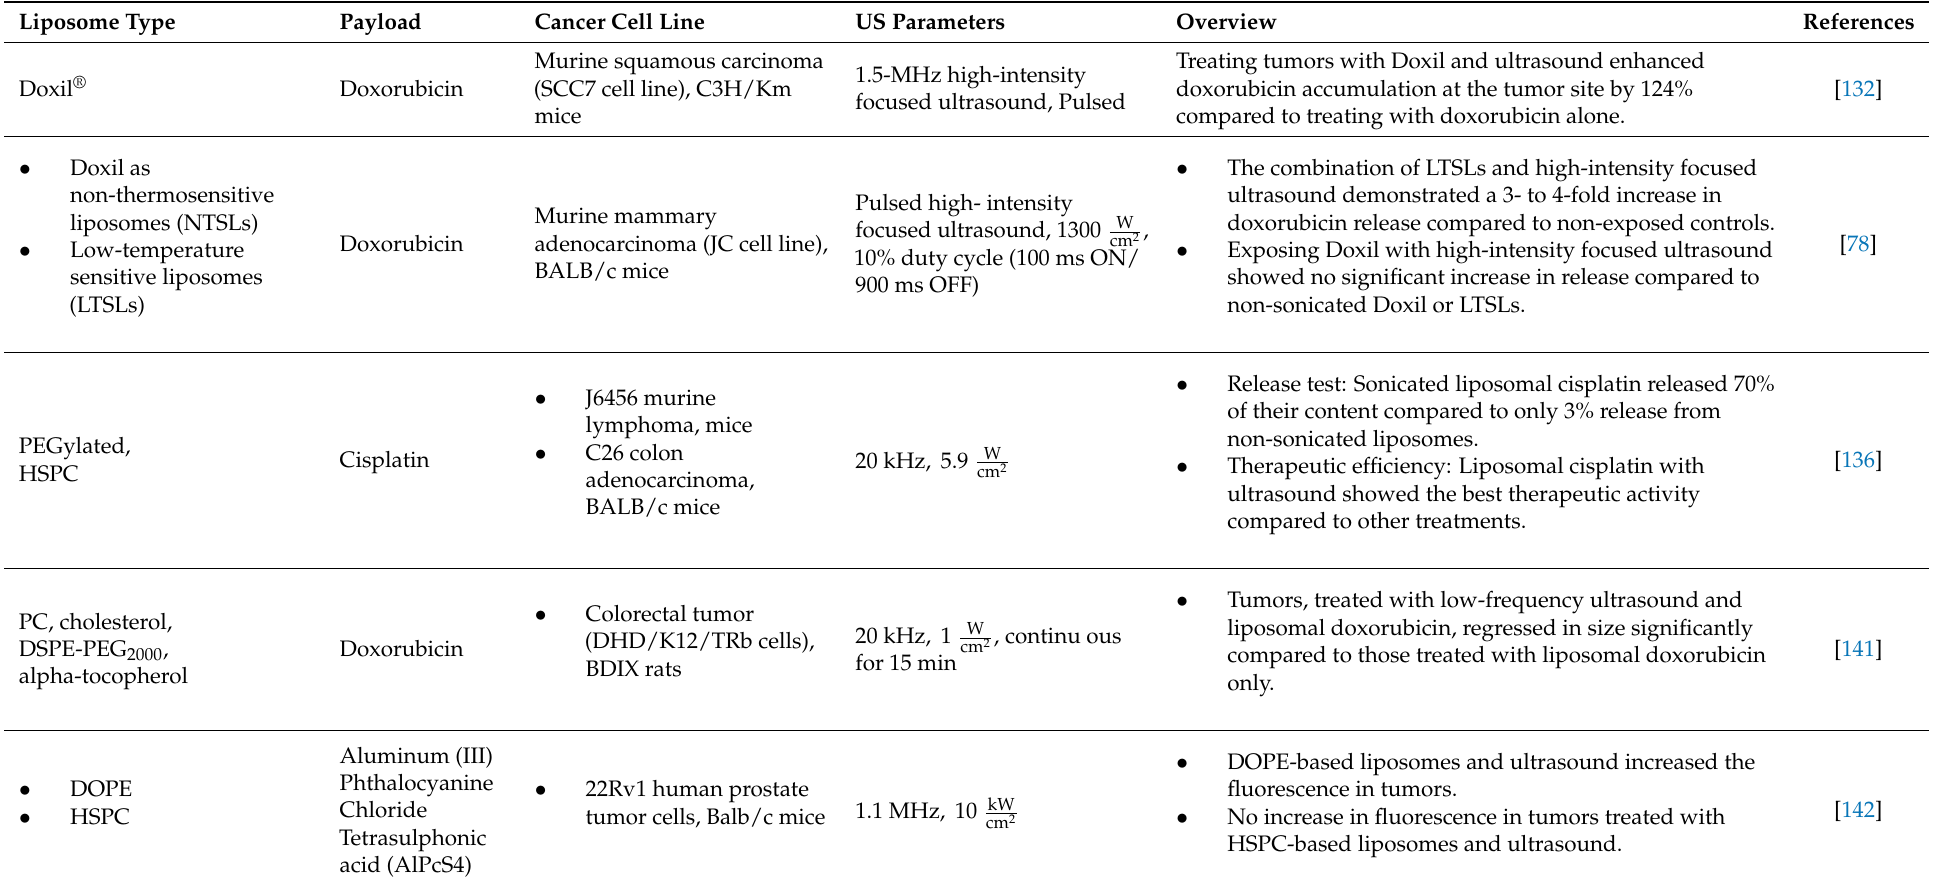
Table 5. In vivo studies using liposomal drugs and ultrasound.